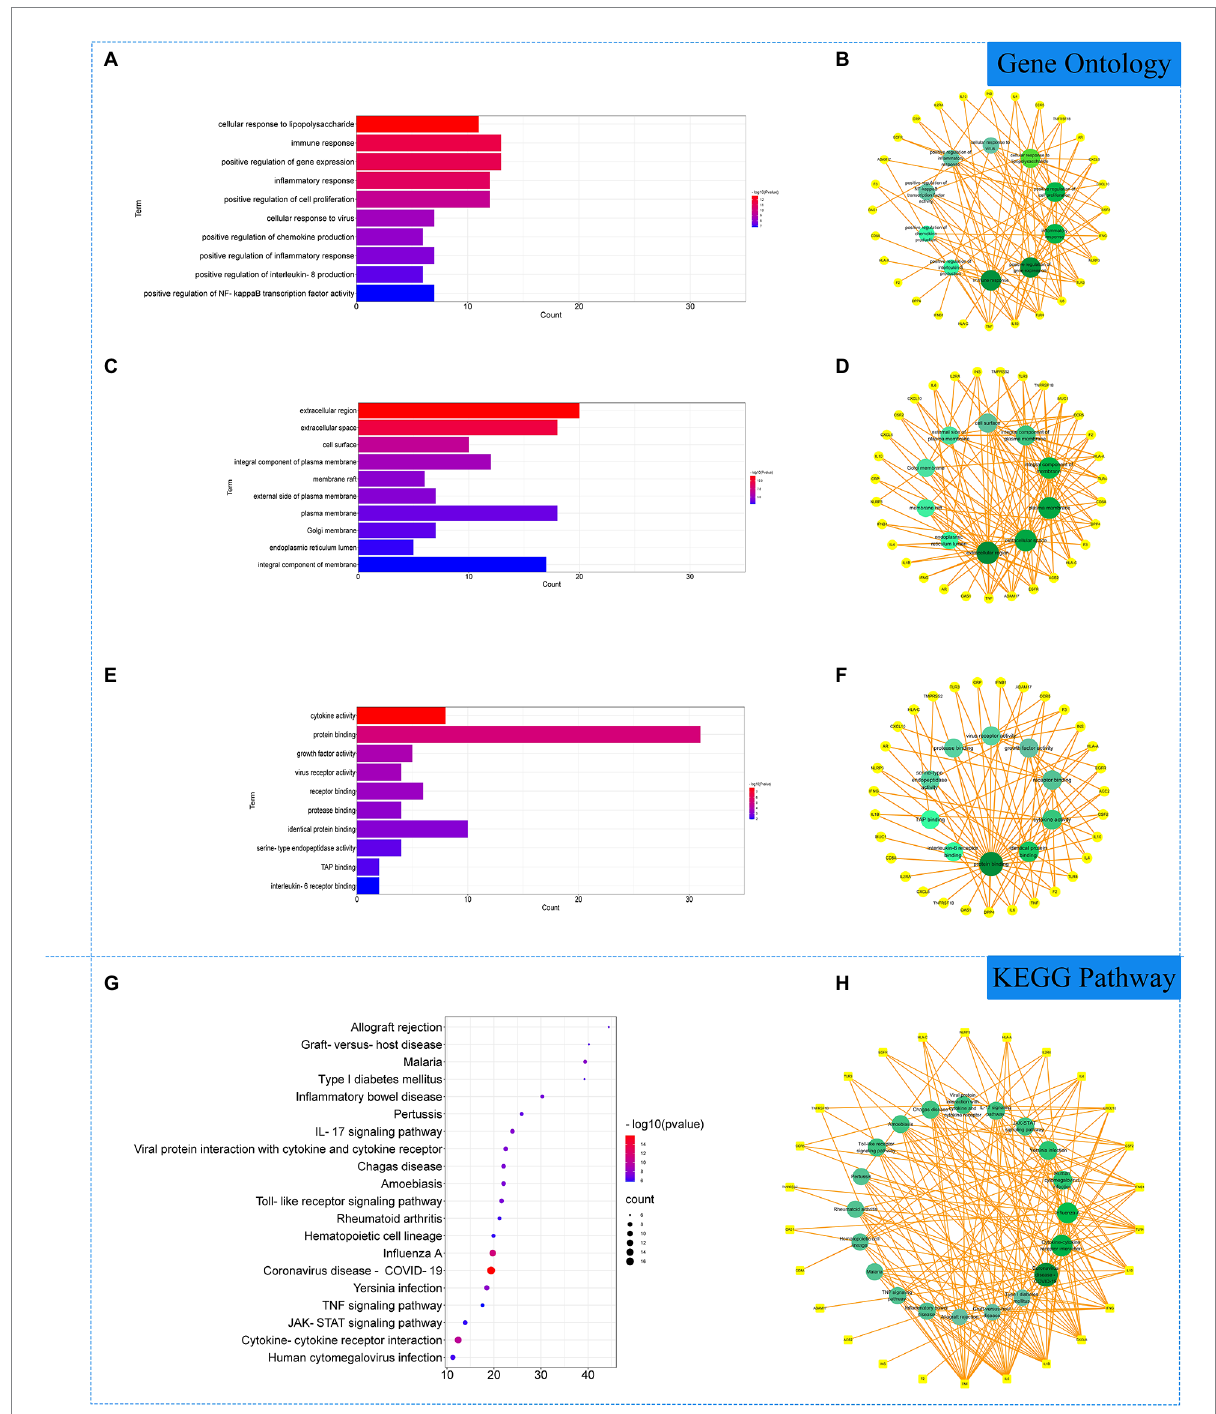
FIGURE 2 Gene Ontology (GO) and Kyoto Encyclopedia of Genes and Genomes (KEGG) analysis of related genes. (A) The top 10 terms in biological processes (BP) were greatly enriched. (B) The subnetwork displayed the top 10 BP terms and related genes. (C) The top 10 terms in cellular components (CC) were greatly enriched. (D) The subnetwork displayed the top 10 CC terms and related genes. (E) The top 10 terms in molecular function (MF) were greatly enriched. (F) The subnetwork displayed the top 10 MF terms and related genes. (G) The top 20 KEGG pathways were showed. (H) The subnetworks displayed the top 20 KEGG